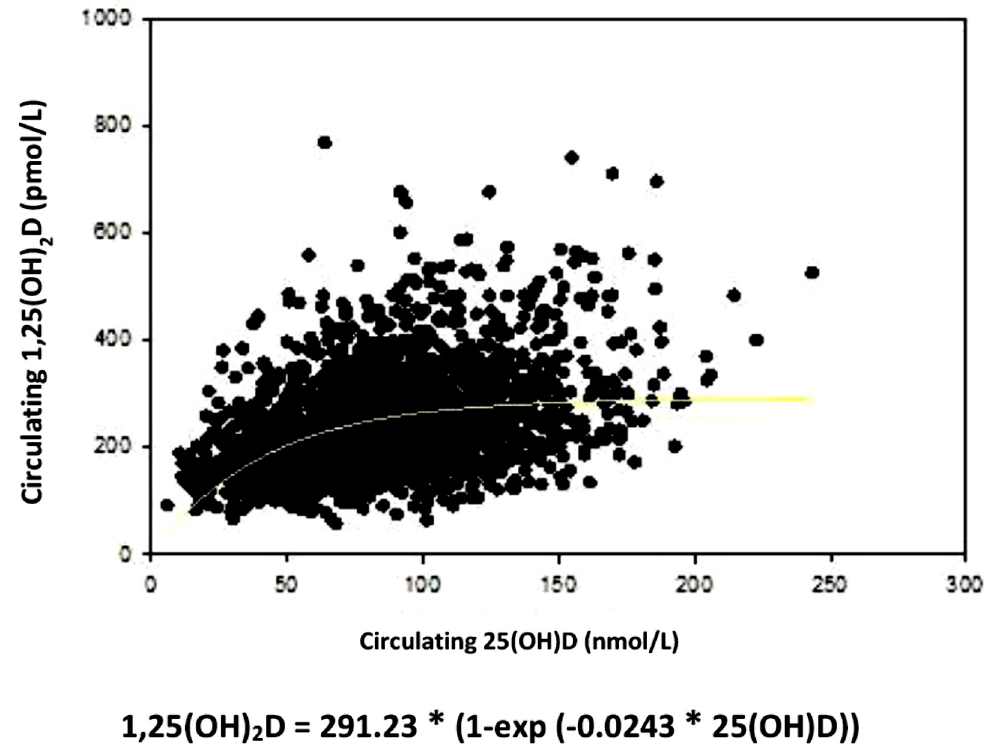
Note: to convert from pmol/L to pg/mL, divide by